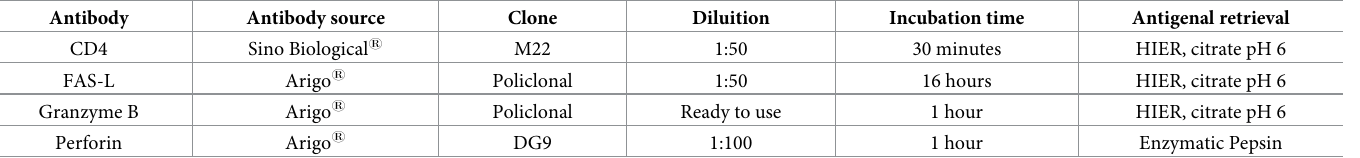
Table 1. Antibody sources, manufacturers, clones, dilutions, incubation times, and antigen retrieval methods.